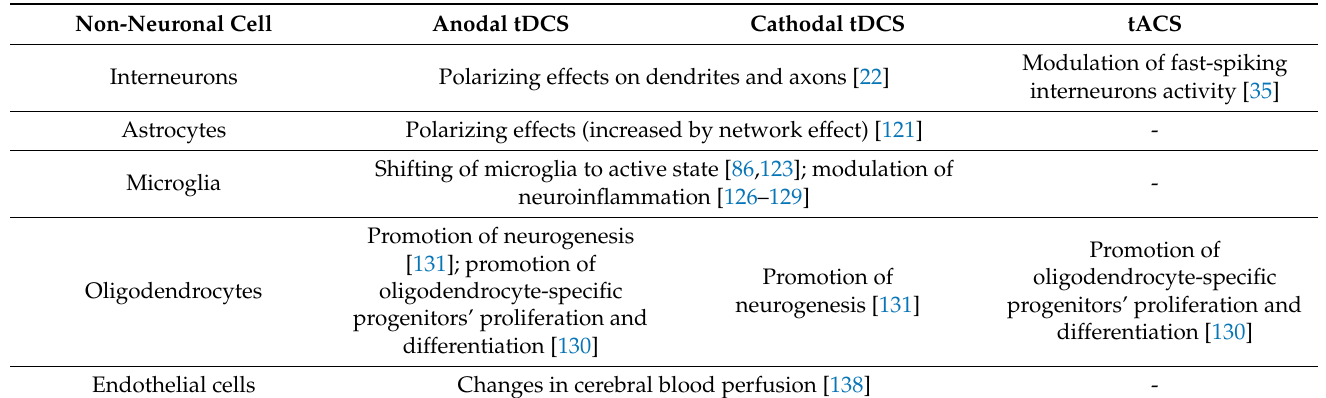
Table 5. Presumed in-vivo effects of transcranial electrical stimulation on non-neural components of the brain at intensities applied in human